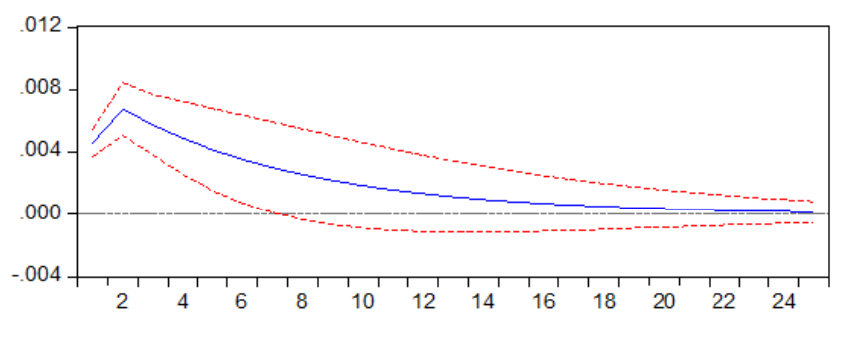
Figure 5. The impulse response of the model ARMA